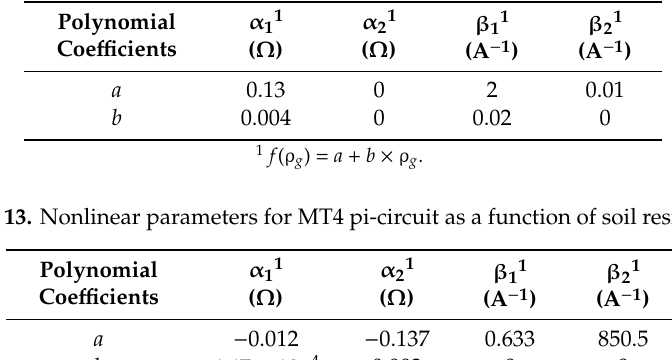
Table 12. Nonlinear parameters for MT3 pi-circuit as a function of soil resistivity.